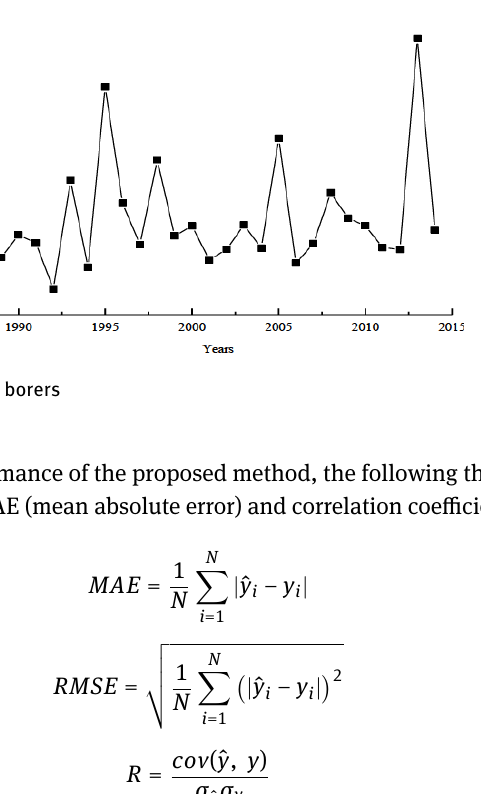
pests can be predicted by regression algorithm. V3CFOA is used in order to avoid local optimum caused by local data, and this approach promises a meet of the expectation.